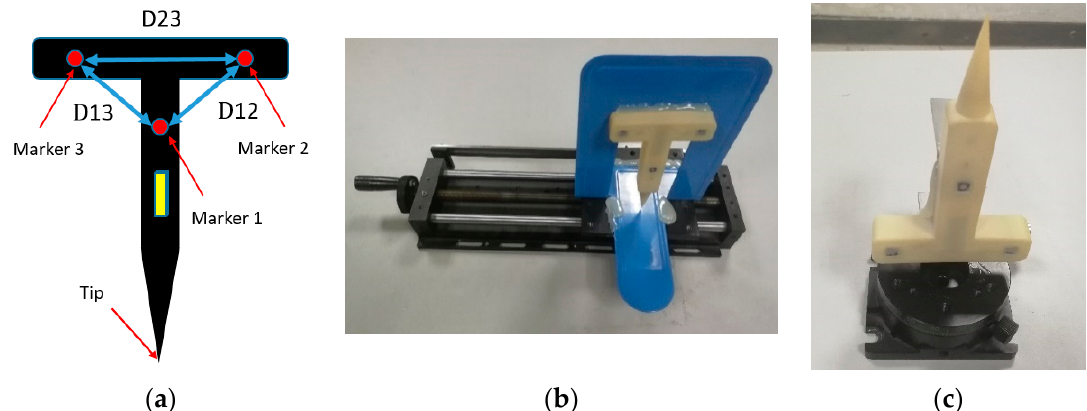
Figure 11. Experimental facilities. ( a ) Model diagram. ( b ) A high-precision translation platform fixed with a tool. ( c ) A high-precision rotary platform fixed with a tool.